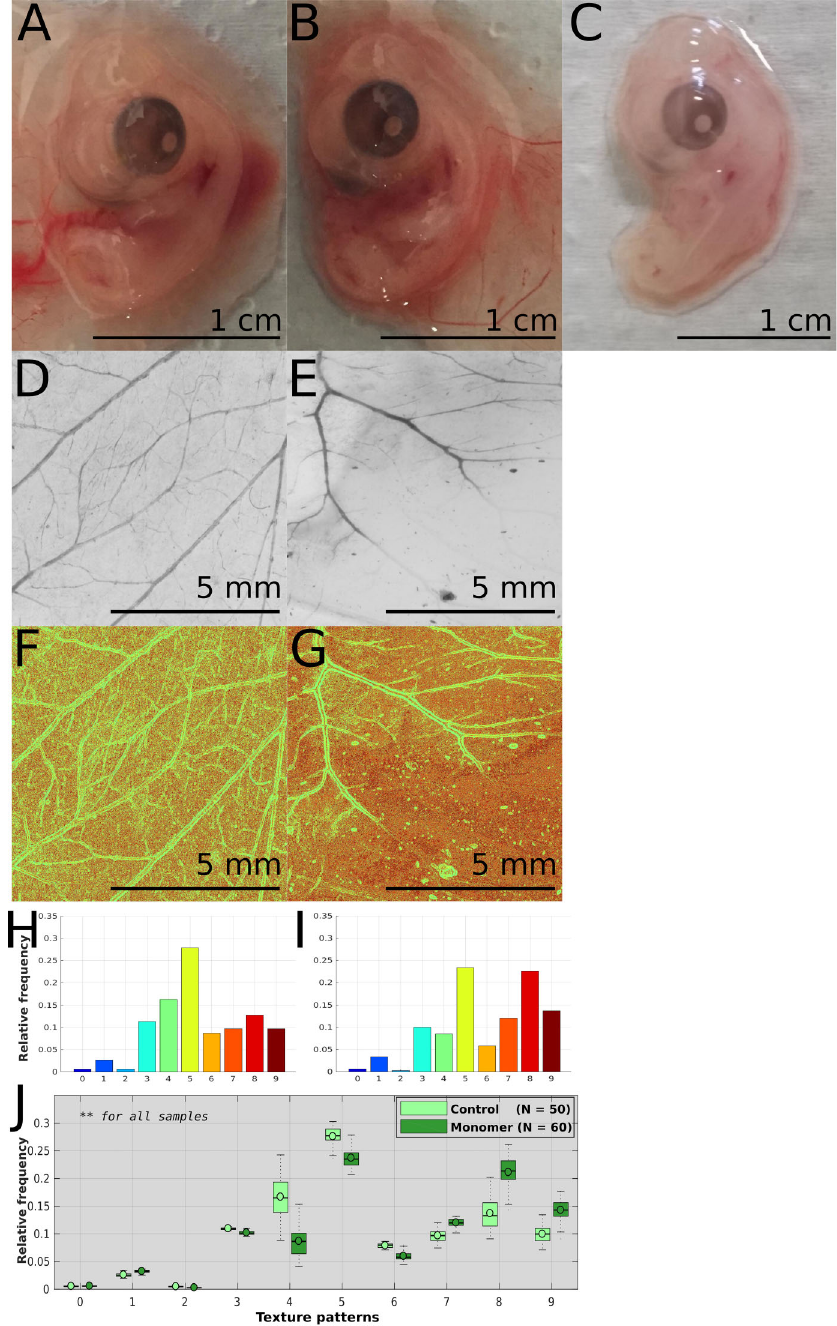
Figure 1. Embryos and chorioallantoic membrane (CAM) morphology data and results as obtained on the 6th day of incubation. A – C , Macroscopic aspect of the embryos (scale bars: 1 cm). D and E , Scanner images of the CAM (scale bars: 5 mm). F and G , Typical quantitative image result obtained after individual Local Binary Patterns image processing (scale bars: 5 mm) and H and I , corresponding histogram. J , Comparative distribution of the CAM results of unexposed controls and embryos exposed to b 2 GPI monomer (2.5 m g/egg). All samples presented **P o 0.01 (the value of N represents the number of fi elds used in the analysis). The CAM of embryos exposed to b 2 GPI dimer (2.5 m g/egg) ( C ) could not be analyzed. Images were taken 48 h after the exposure to b 2 GPI puri fi cation fractions and vehicle, or vehicle only in their respective controls. Images A – C were taken with Canon Powershot G12 equipment. Images D – E were taken with a 1200 dpi resolution scanner under transillumination and high-resolution settings. Signi fi cant differences between controls and treatments were determined with the Kruskal-Wallis test using MATLAB s software